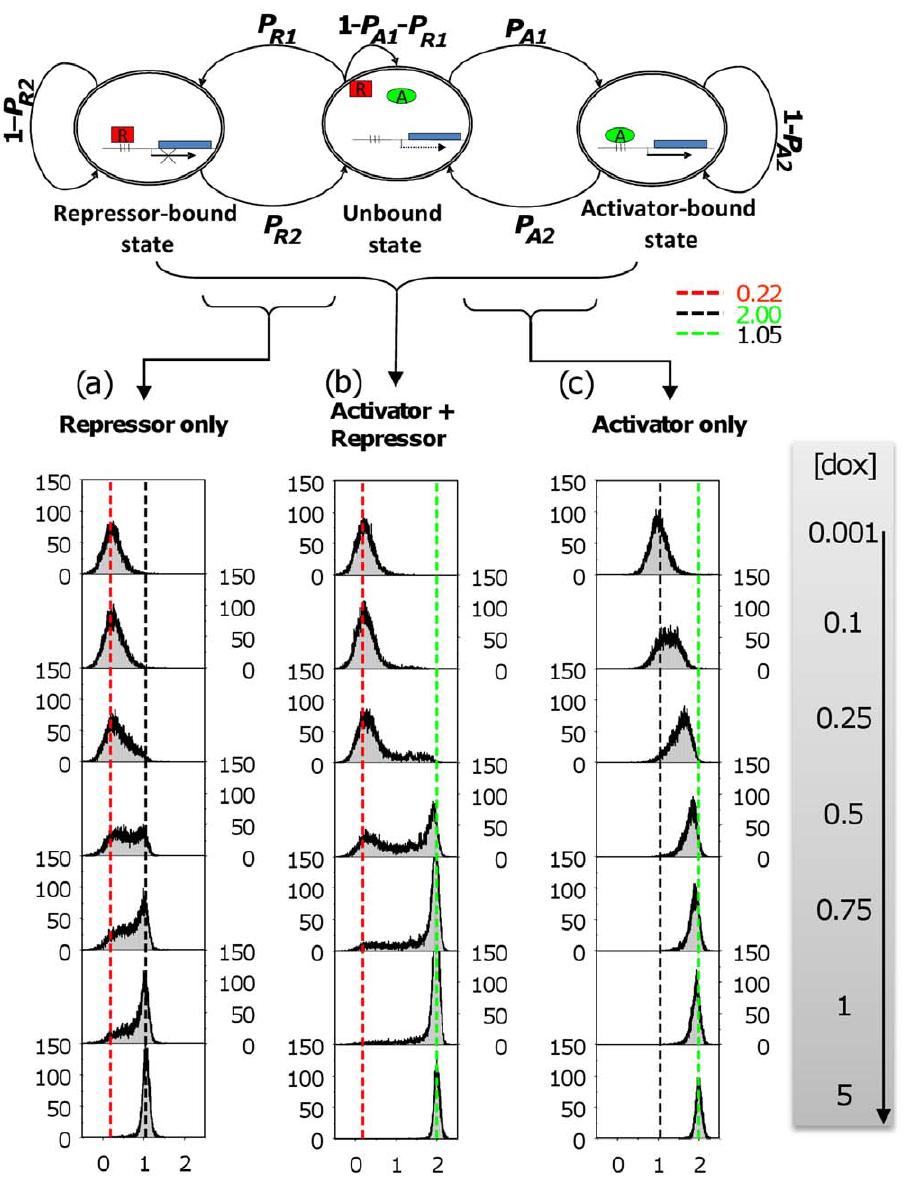
Figure 3. Stochastic simulation using a 3-state MCM yields all-or-none responses. In a cell population, steady-state distributions of gene induction were stochastically simulated by the 3-state MCM using the estimated parameters described in Figure 2. Red, black, and green lines present the peaks of transcription levels in the ‘‘repressor-bound,’’ ‘‘unbound,’’ and ‘‘activator-bound’’ states, respectively. A gray vertical bar indicates the increasing concentrations of [dox], which correspond to the experimental conditions reported in [20].